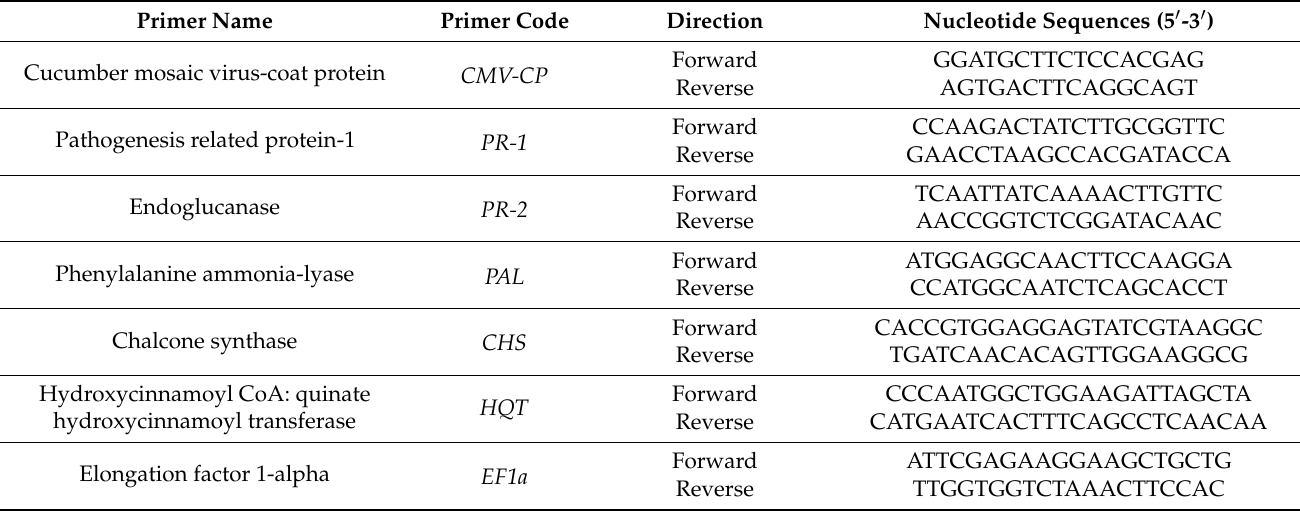
Table 1. Primers used in this